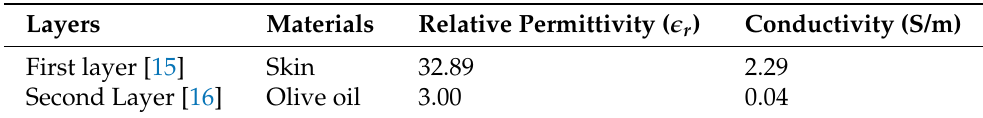
Table 2. The relative permittivity and conductivity of skin and olive oil used to create the double- layered configurations at 4 GHz for